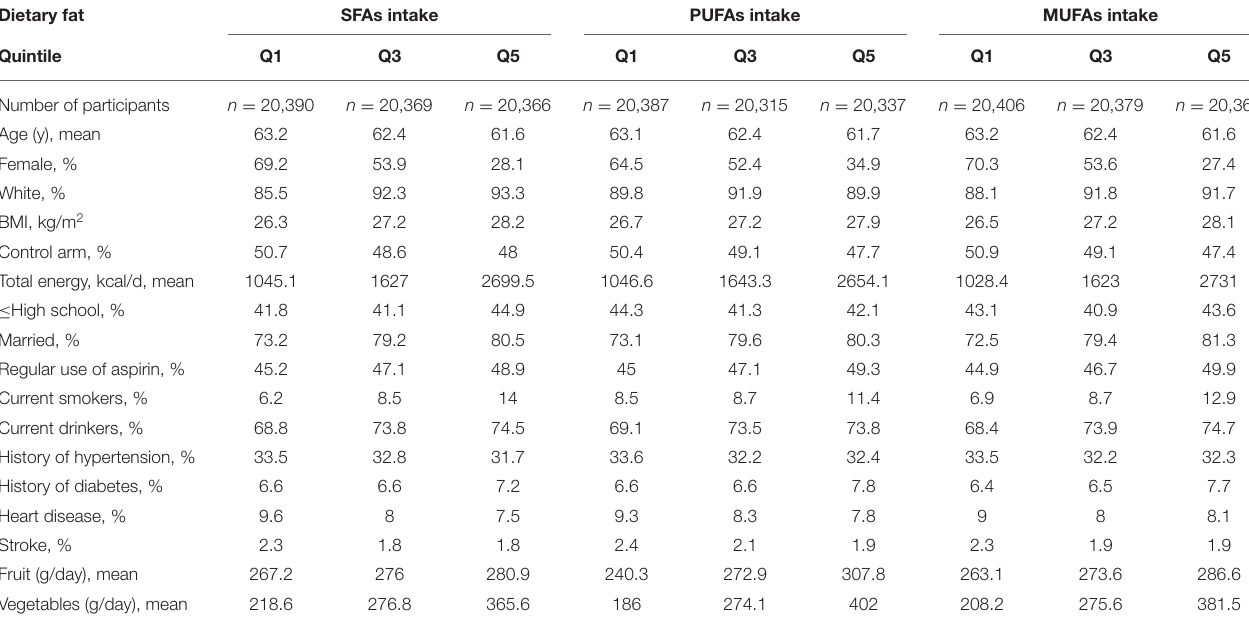
TABLE 1 | Characteristics of the participants by quintiles of dietary fat intake in the PLCO study. Dietary fat SFAs intake PUFAs intake MUFAs intake